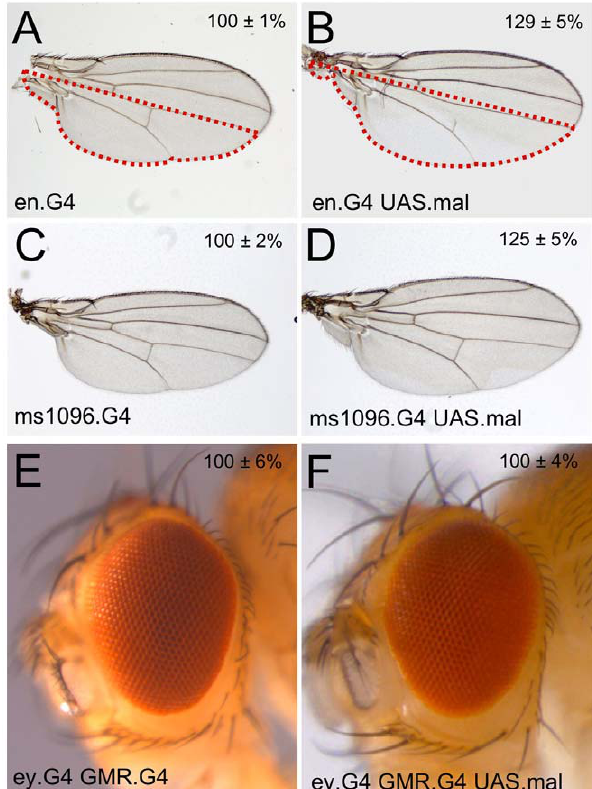
Figure 2. Overexpression of Mal causes overgrowth in the wing, but not the eye. (A) A control en.Gal4 wing. (B) Overexpression of Mal in the posterior compartment with en.Gal4 causes overgrowth. (C) A control ms1096.Gal4 wing. (D) Overex- pression of Mal in the whole wing with ms1096.Gal4 causes overgrowth. (E) A control ey.Gal4 GMR.Gal4 eye. (F) Overexpre- ssion of Mal in the eye with ey.Gal4 GMR.Gal4 does not affect eye